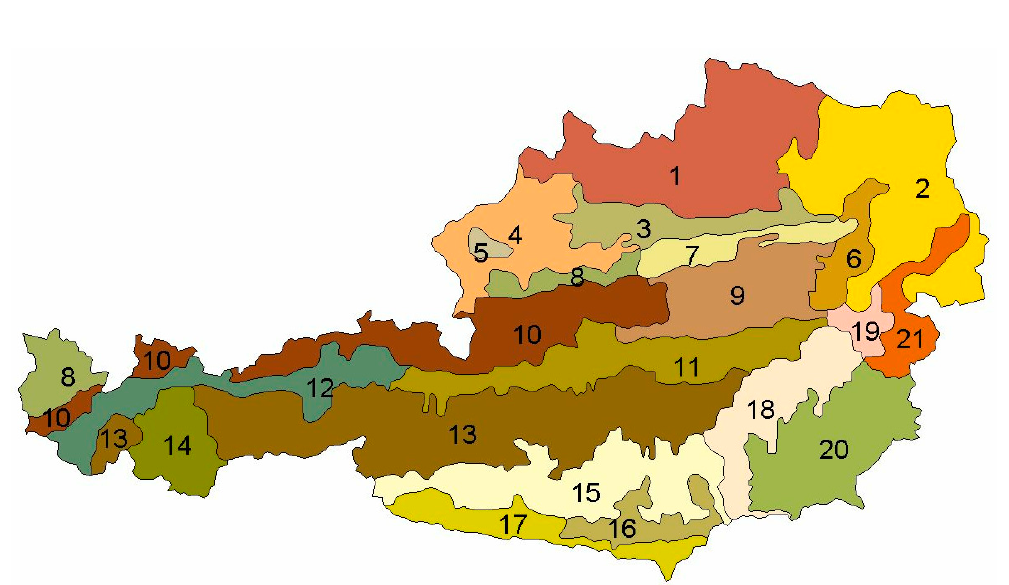
Figure A1. The growth regions of Austria. 1, The Austrian part of the Bohemian Massif; 2, eastern pannonic semiarid region; 3, hills and plain between the Alps and Danube, eastern part; 4, hills and plain between the Alps and the Danube, western part; 5, Kobernausserwald; 6, eastern edge of the Alps with subillyric climate; 7, eastern Flysch-Alps; 8, western Flysch-Alps with humid climate; 9, northern calcareous Alps; 10, northern calcareous Alps, western part; 11, northern central Alps, eastern part; 12, northern central Alps, western part; 13, central Alps; 14, inner central Alps, western part; 15, southern central Alps; 16, Klagenfurt valley (inner alpine valley with long frost periods in winter); 17, Austrian Southern Alps; 18, southeastern edge of the Austrian Alps; 19, granite hills on the eastern edge of the Alps; 20, southeastern hills and terraces; 21, mountain of the middle “Burgenland”.